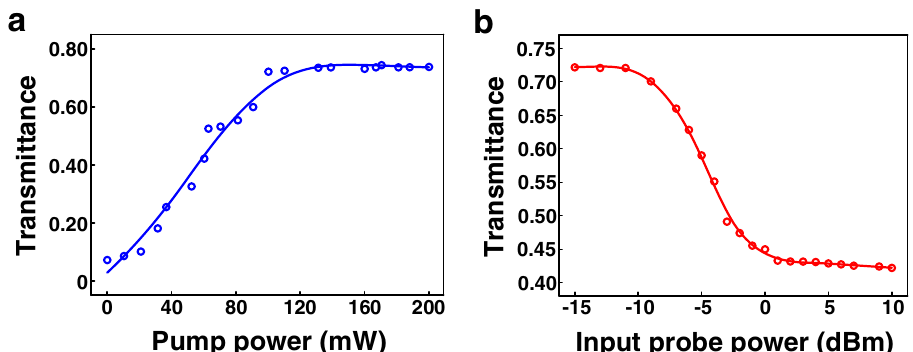
Fig. 3 Gain saturation response. Gain saturation response of a single FP resonator shown in Fig. 2c, a with a fi xed probe power of -15 dBm, and b with a fi xed pumping power of 100 mW. The effective mode fi eld diameter of the fi ber is 6.9 μ m.